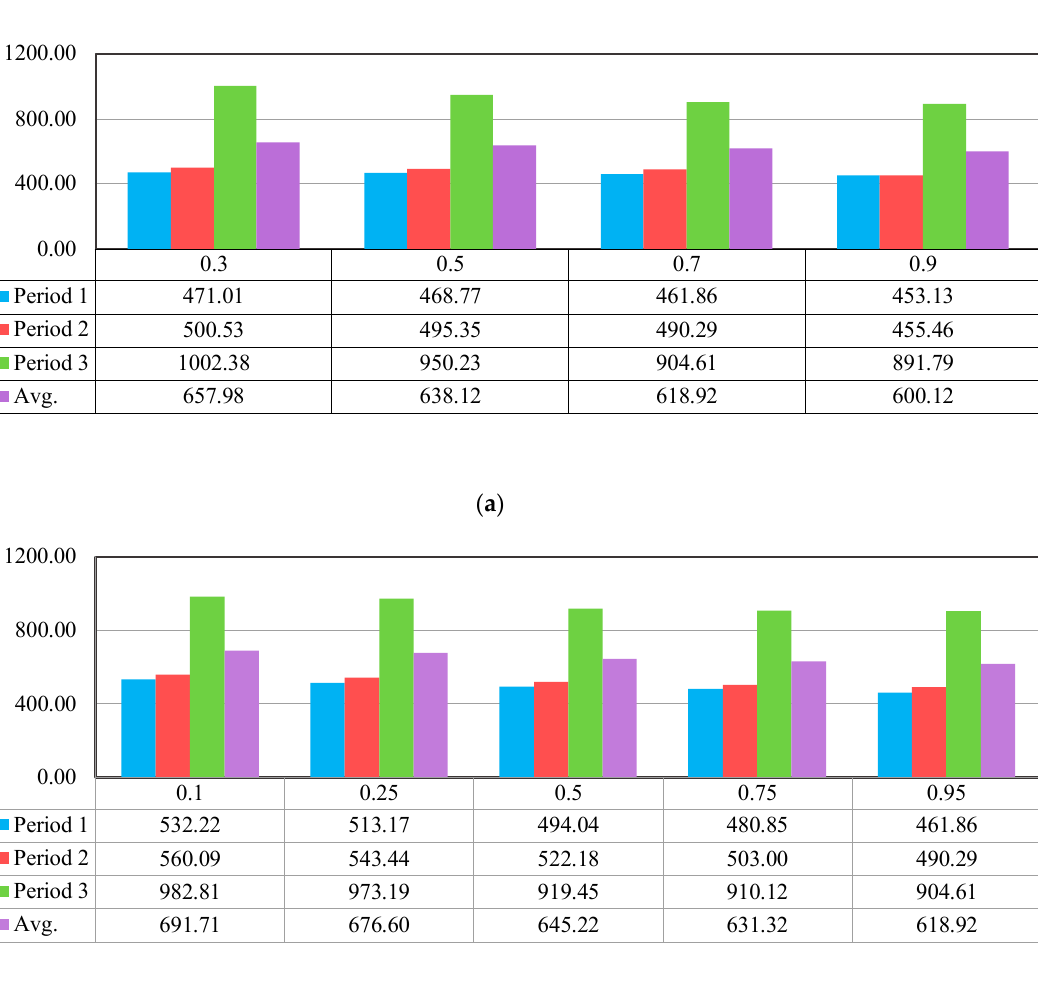
Figure 5. Sensitivity analysis on: α 1 ( a ); and α 2 ( b